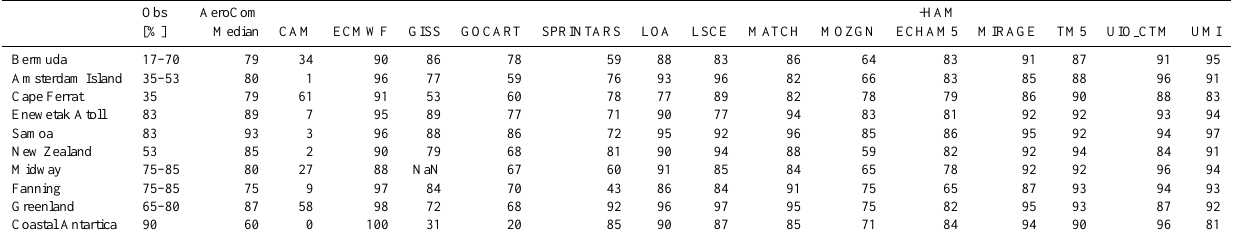
Table 4. Fraction of wet deposition [%]. The compilation is taken from Mahowald et al. (2010). Obs AeroCom -HAM